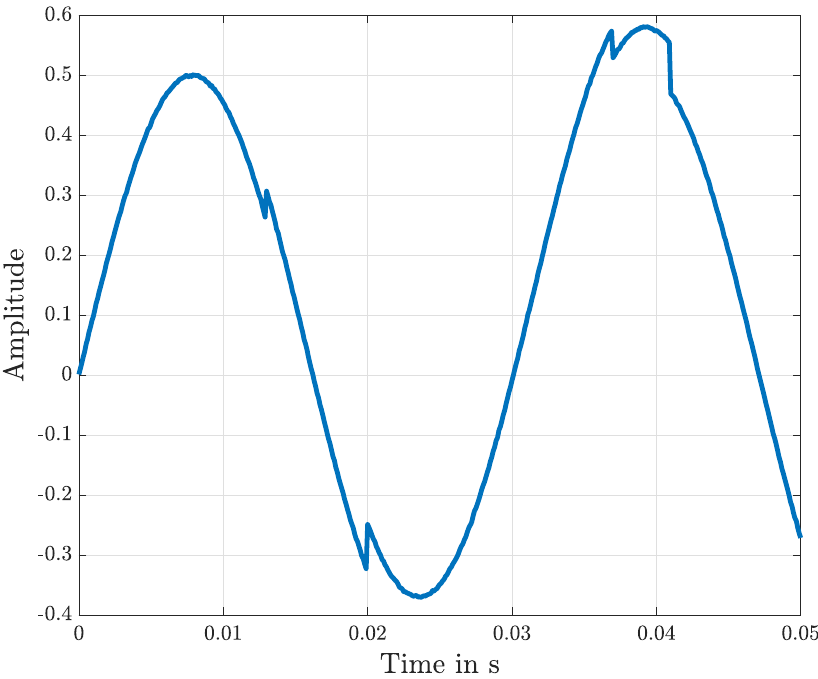
Figure 7. Graphical representation of the position y ( t ) with noise and